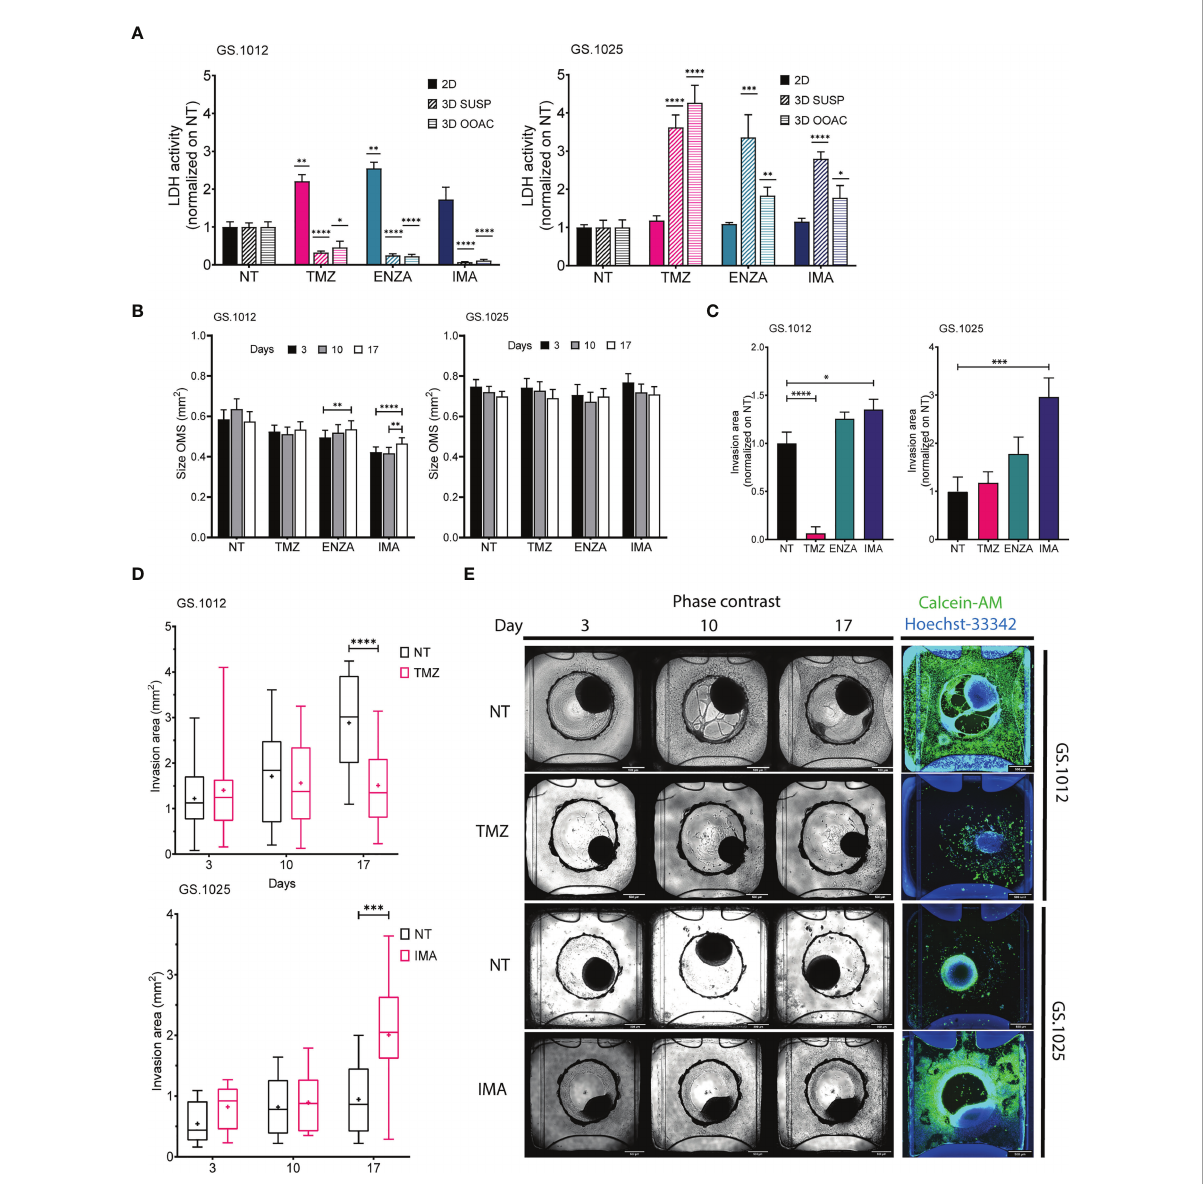
FIGURE 3 LDH activity, size, and migration of GS.1012 and GS.1025 3D cell cultures. (A) Bar plots showing the LDH activity in 2D, 3D-SUSP and 3D-OOAC samples of GS.1012 (left) and GS.1025 (right) in temozolomide (TMZ), enzastaurin (ENZA) and imatinib (IMA) treated samples normalized to values observed in non-treated (NT) control. n(2D)=3; n(3D-GS.1012)=24; n(3D-GS.1025)=16. Data are presented as mean ± SD. *p < 0.05; **p < 0.01; ***p <0.001; ****p <0.0001. (B) Bar plots showing the size variation in time of 3D-SUSP OMS of GS.1012 (left) and GS.1025 (right) samples in non-treated (NT), temozolomide (TMZ), enzastaurin (ENZA) and imatinib (IMA) treated conditions. n(GS.1012)=24; n(GS.1025)=16. Data are presented as mean ± SEM. **p < 0.01; ***p <0.001; ****p<0.0001. (C) Bar plots showing the invasion area of 3D-OOAC OMS of GS.1012 (left) and GS.1025 (right) samples in temozolomide (TMZ), enzastaurin (ENZA) and imatinib (IMA) treated conditions normalized on non- treated (NT) control. n(GS.1012)=24; n(GS.1025)=16. Data are presented as mean ± SEM. *p<0.05; ***p <0.001; ****p<0.0001. (D) Invasion area of 3D-OOAC OMS through treatment time in GS.1012 and GS.1025. Box plots show the distribution of the invasion area of 3D-OOAC OMS of GS.1012 (top) through treatment time, in untreated (NT) and temozolomide (TMZ) condition. Box plots show the distribution of the invasion area of 3D-OOAC OMS of GS.1025 (bottom) through treatment time, in untreated (NT) and imatinib (IMA) conditions. The middle line represents the median. The cross represents the mean. n(GS.1012)=24; n(GS.1025)=16. ***p <0.001; ****p<0.0001. (E) Development of OMS in the Organoplate ® Graft. The top half panels show representative images of GS.1012 OMS in the untreated (NT) and temozolomide (TMZ) conditions in the Organoplate®Graft after 3, 10, and 17 days. The bottom half panels show representative images of GS.1025 OMS in the untreated (NT) and imatinib (IMA) conditions in the Organoplate ® Graft after 3, 10, and 17 days. On the right, the OMS are stained with Calcein-AM to identify the living